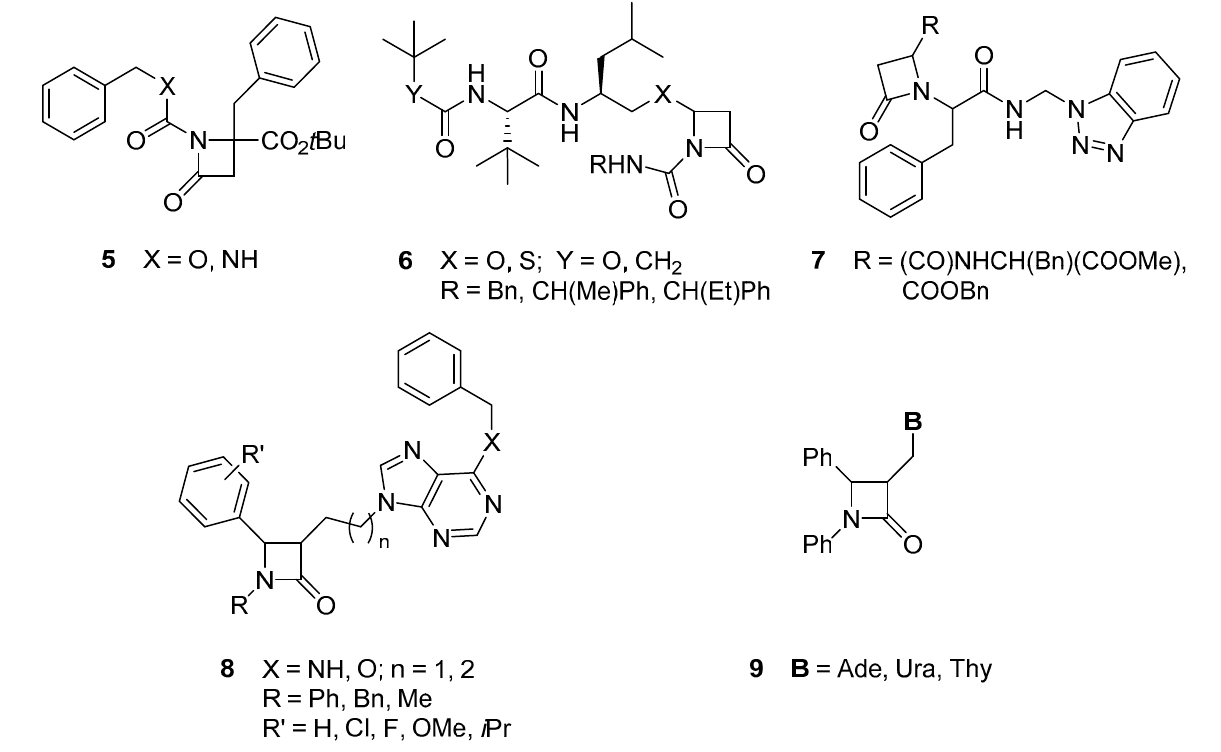
Figure 2. Example of azetidinones exhibiting antiviral activity.